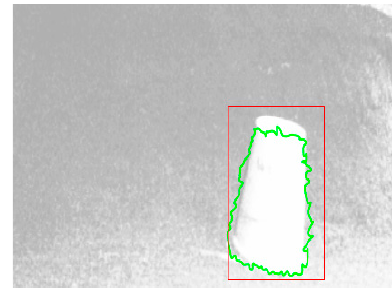
Figure 7. Obstacle detection diagram.